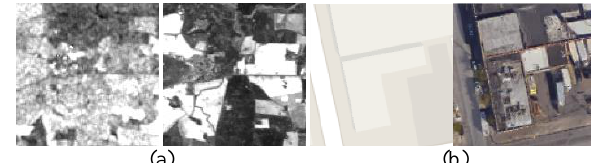
Figure 1 Example of different intensity and texture patterns between multimodal remote sensing images. (a) SAR (left) and visible (right) images. (b) Map (left) and visible (right) images.